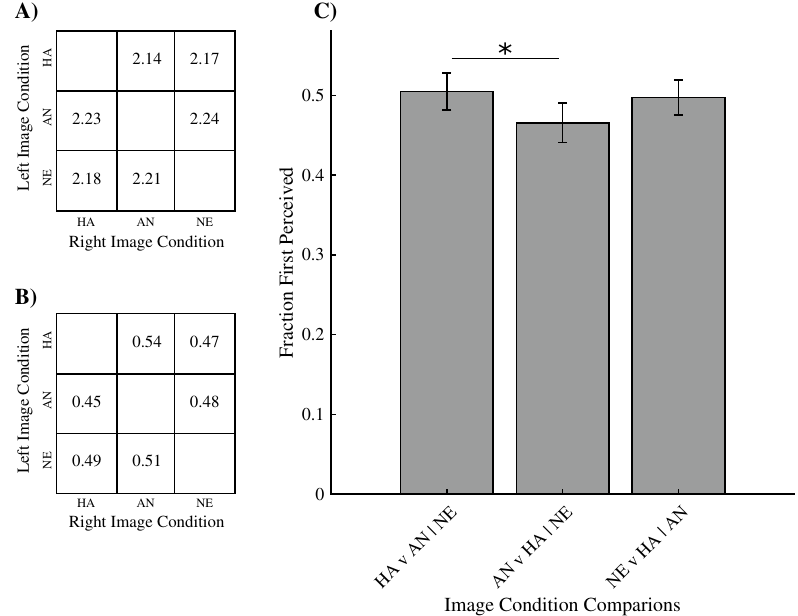
Figure 1. ( A ) Average median reaction time in seconds across participants per presentation condition. The y-axis shows the image class (HA: happy, AN: angry, NE: neutral) of the image presented on the left of fixation, the x-axis shows the image class of the image presented on the right of fixation. ( B ) Average fraction of the left image being perceived first across participants per presentation condition. The y-axis shows the image class of the image presented on the left of fixation with the x-axis shows the image class of the image presented on the right of fixation. ( C ) Main results showing the fractions initially detected images during bCFS (y-axis) for different presentation conditions. Specifically, from left to right on the x-axis, the fraction of happy expressions being perceived first when presented together with either angry or neutral expressions, the fraction of angry expressions being perceived first when presented together with either happy or neutral expressions, and the fraction of neutral expressions being perceived first when presented together with either happy or angry expressions. Therefore, the fraction on the y-axis is the fraction that a particular image class (on the x-axis) is detected first whenever it was presented. Results show that happy faces are detected first more frequently than angry faces (asterisk indicates